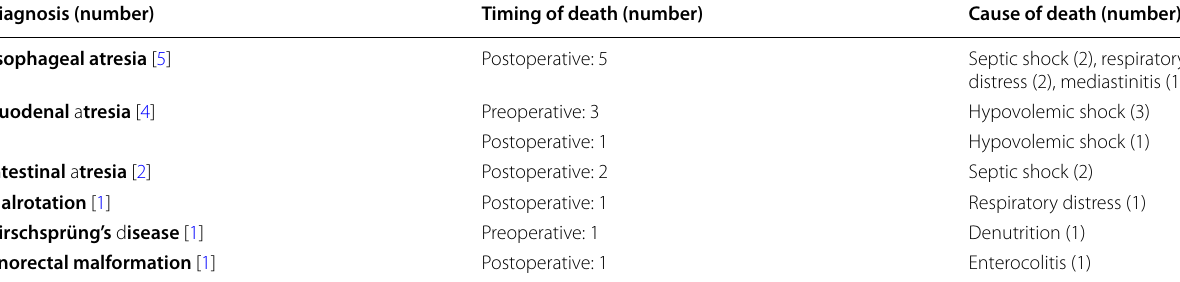
Table 4 Mortality